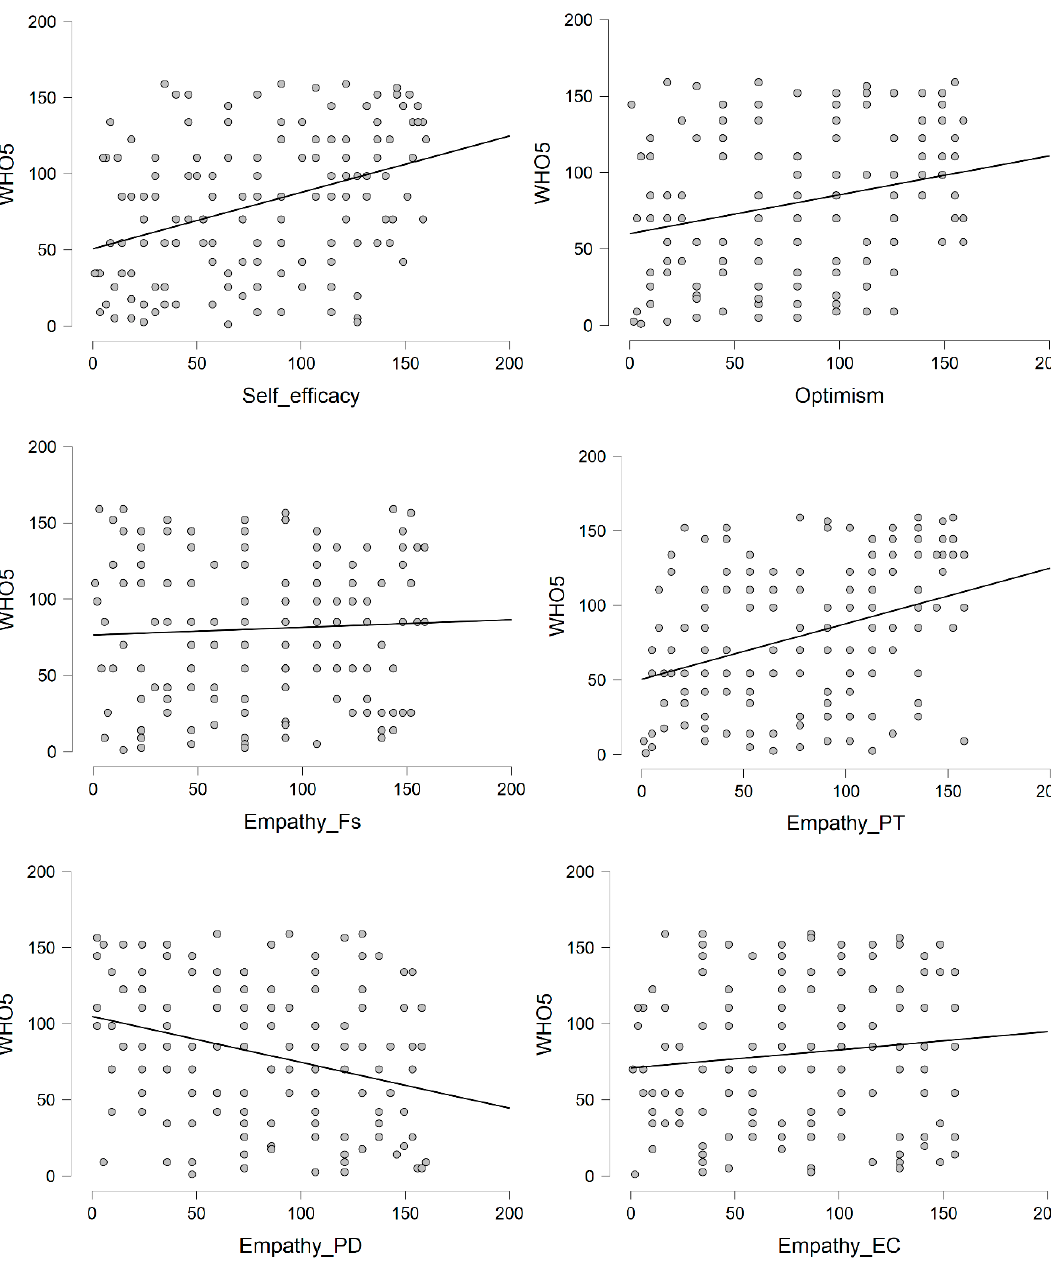
Figure 2. Scatterplots of correlations of subjective well-being with other psychological variables. WHO-5 = Subjective well-being; Fs = Fantasy; PT = Perspective Taking; PD = Personal Distress; EC = Empathic Concern.